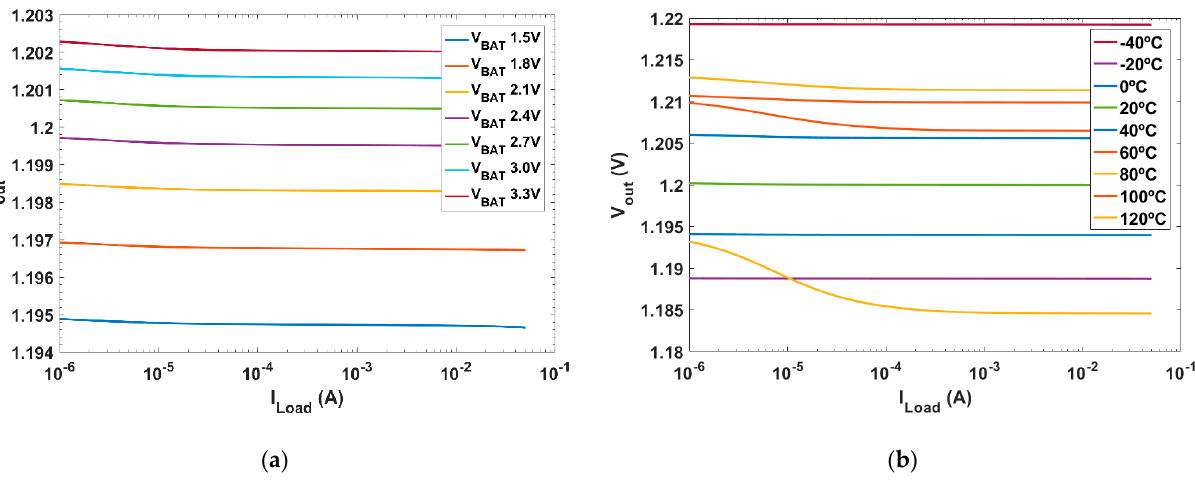
Figure 14. Load regulation for different: ( a ) battery voltages and ( b ) temperatures (with V BAT = 2.5 V).